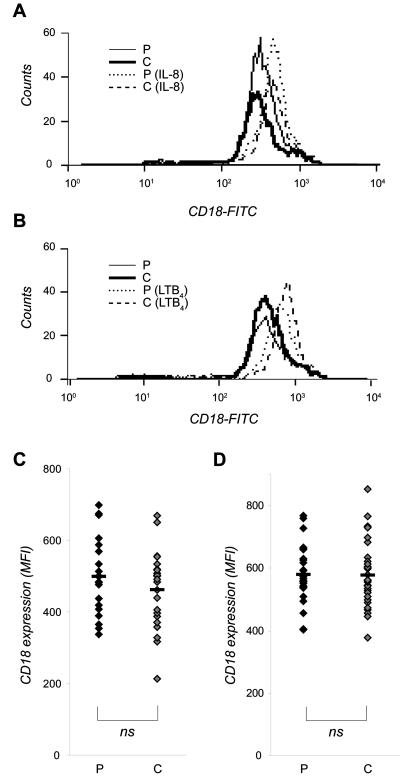
IL-8 and LTB4 induced expression of CD18 on neutrophils from patients with stable CAD.Whole blood from patients (P) and individually matched control persons (C) were stimulated for 10 min at 37°C with (A,C) IL-8 (10 ng/mL) or (B,D) LTB4 (100 nM), and the samples were co-incubated with the MHM23-antibody during the last 5 min of stimulation. The stimulation was stopped by incubation the samples on ice, and contaminating erythrocytes were removed by lysis. Antibody bound to CD18 was detected by FACS analysis. The cells were gated to identify the neutrophil population, and 10 000 cells were counted in each sample. Data are shown as one representative histogram plot (A,B) or as median of the mean fluorescence intensity (MFI) values (C,D) from 22 (A,C) and 30 (B,D) experiments per cohort done in triplicate. Mean value is indicated as a black hyphen. Wilcoxon signed-ranks test was used to determine significance between each patient and its individually matched control.